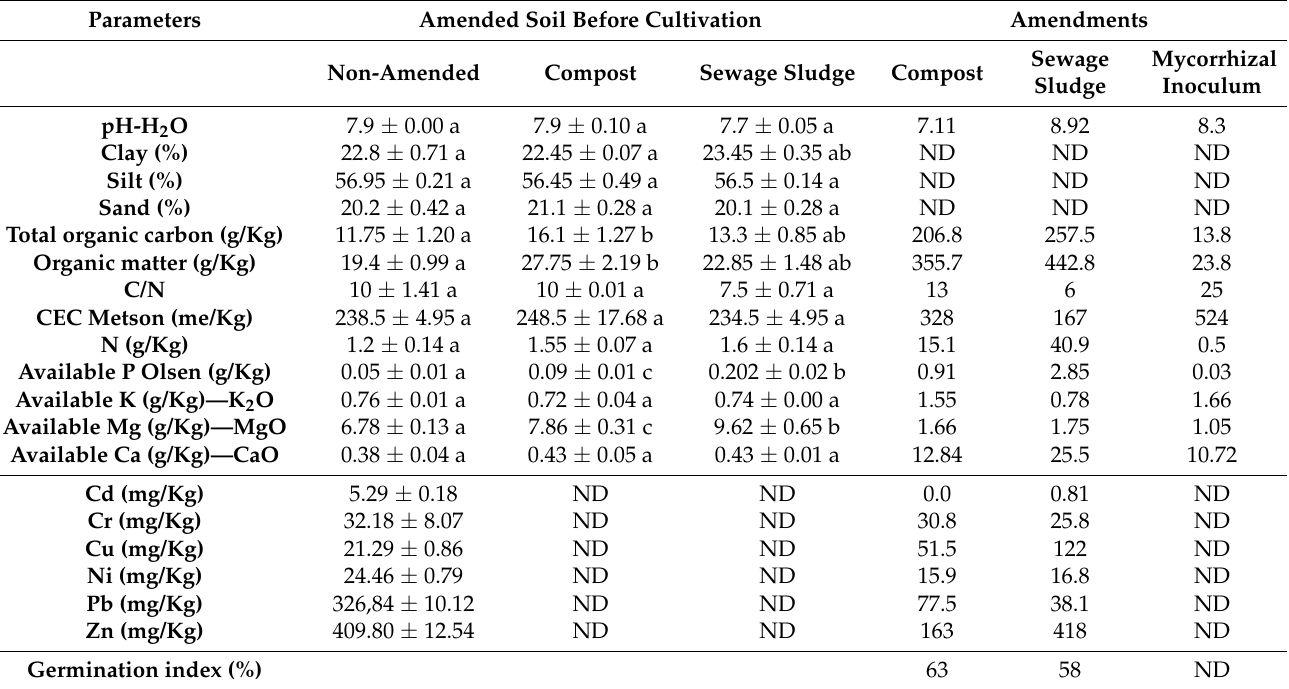
Table 1. Physicochemical properties of the initial soils after the amendment introduction and physic- ochemical properties of the amendments